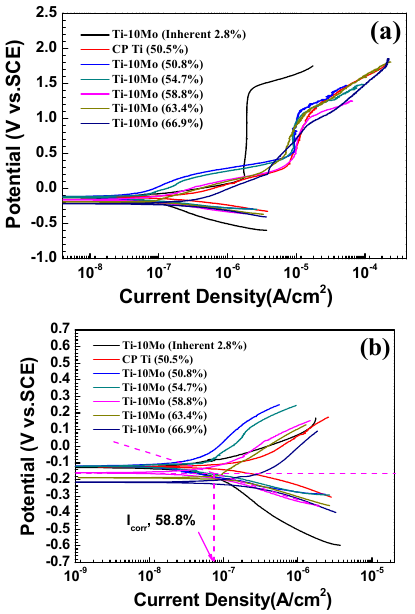
Figure 8. ( a ) Potentiodynamic polarization curves of different Ti samples during exposure to naturally aerated phosphate-buffered saline solution at (37 ± 0.5) °C; ( b ) Tafel extrapolation on the cathodic polarization plots for determination of corrosion current density ( I corr ) and cathodic Tafel slope ( β c ).